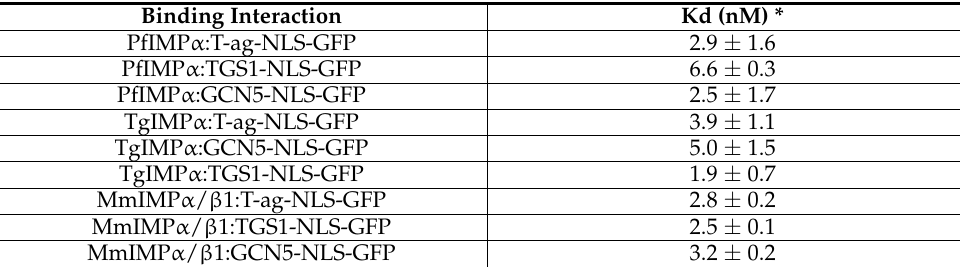
Figure 1. PfIMP α , TgIMP α , and MmIMP α / β 1 all show high-affinity binding to NLSs from diverse sources. AlphaScreen technology was used to determine the binding affinity of biotinylated IMP α s binding to His-tagged NLS-GFPs (30 nM). Data points represent the mean ± SEM from quadruplet wells from a single typical experiment from a series of two independent experiments (see Table 1 for pooled data). Table 1 . Summary of NLS binding studies using AlphaScreen technology.